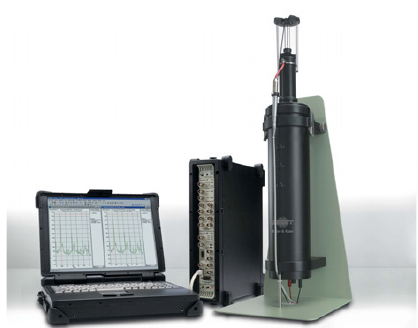
Fig. 16. The B&K high-pressure system for testing of dy- namic linearity and distortion of measurement microphones and sound level meters. The system is optimized for low dis- tortion of the generated sound and for low vibration excitation of the